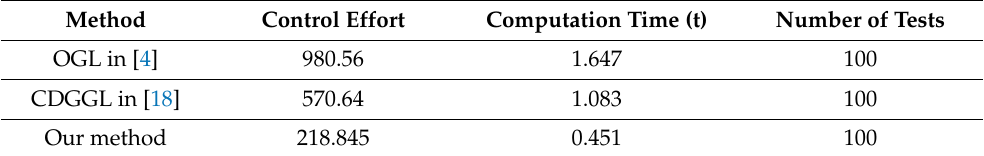
Table 1. Comparison results of OGL, CDGGL, and our